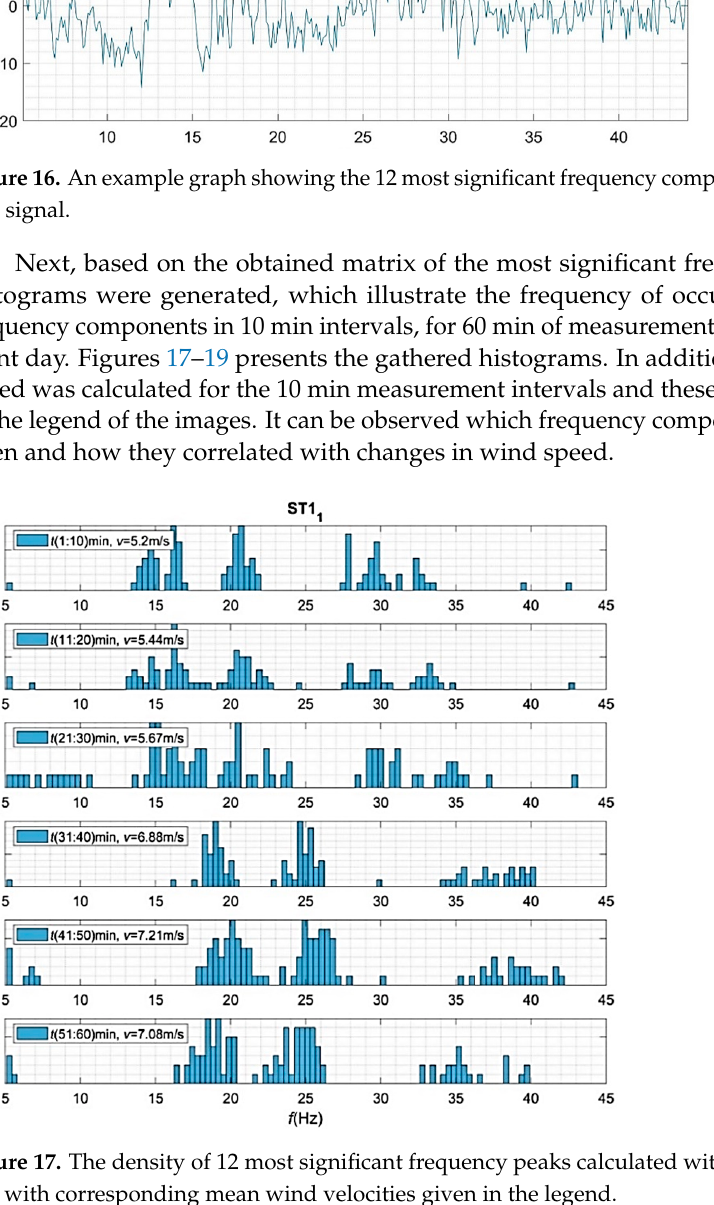
Figure 16. An example graph showing the 12 most significant frequency components in the detrended SPL signal.